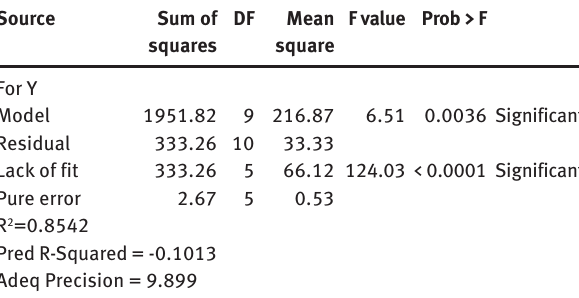
Table 2: ANOVA analysis for responses Y [uranium removal efficiency